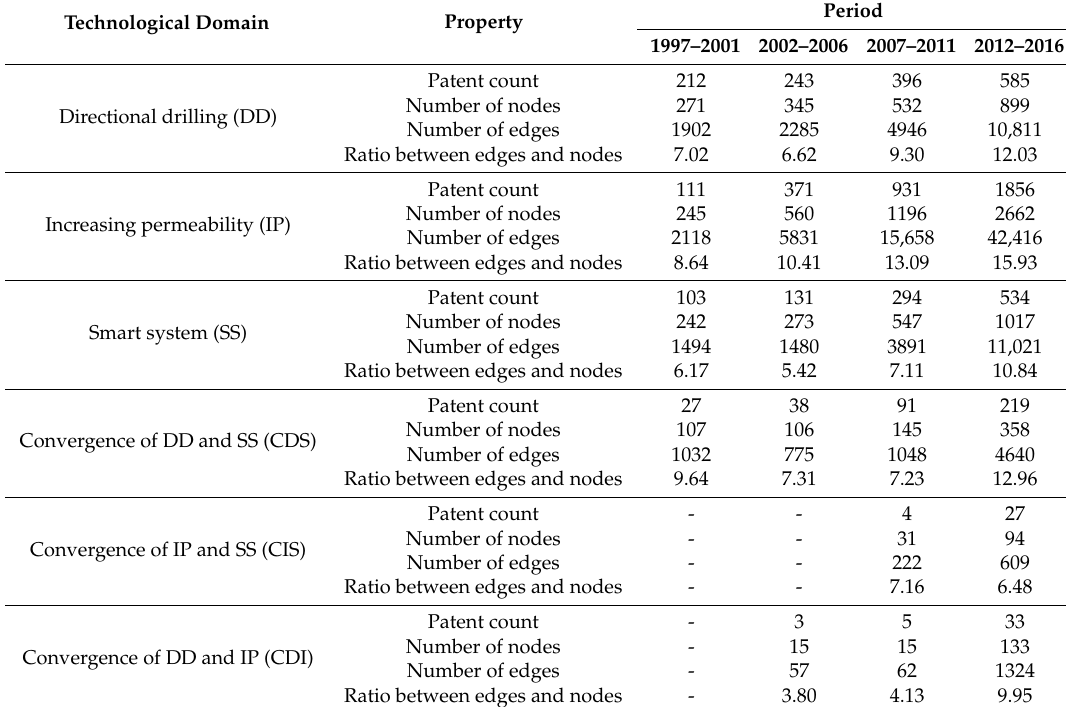
Table 4. Network properties by technological domains.